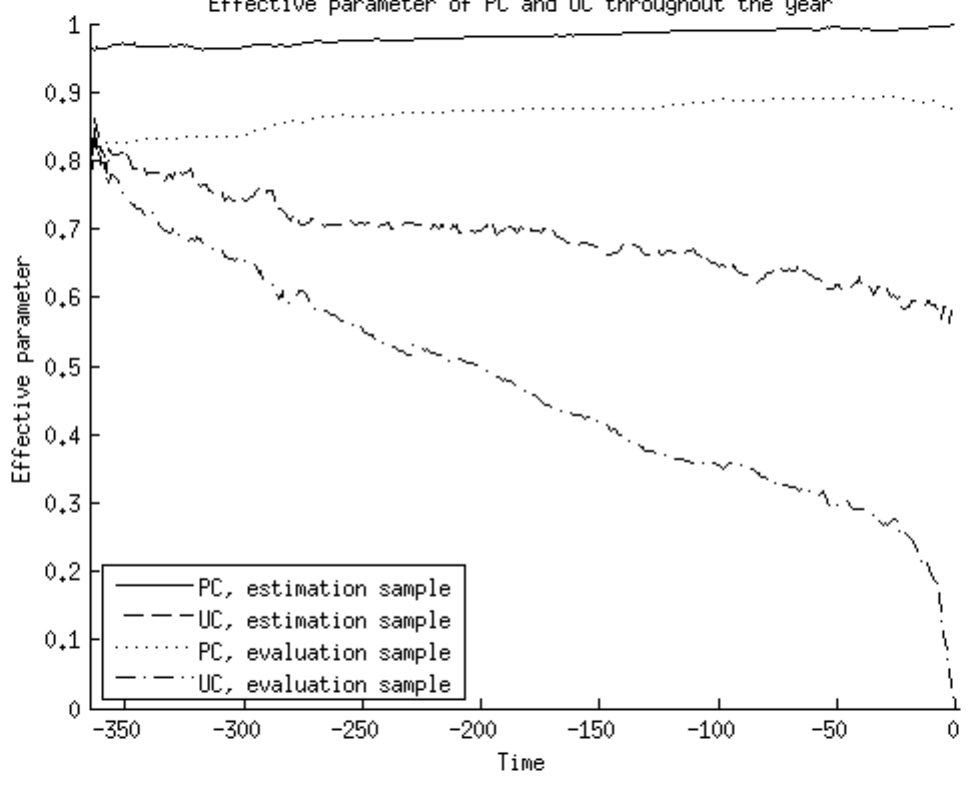
Figure 2. The effective parameter of the predictable and unpredictable component in forecasting the actual earnings throughout the year (with earnings announcement at t = 0), after filling in average actual values for the number of forecasts and time until announcement across all firms and all years in the estimation or evaluation